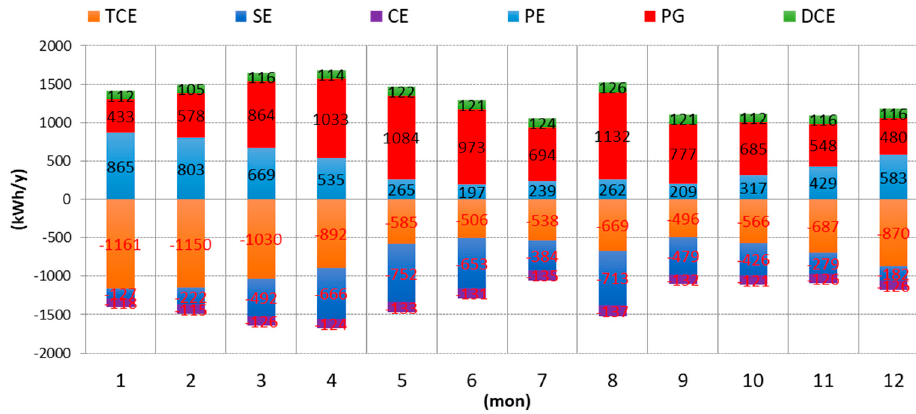
Figure 8. Monthly energy balance for PV8 SB (S).